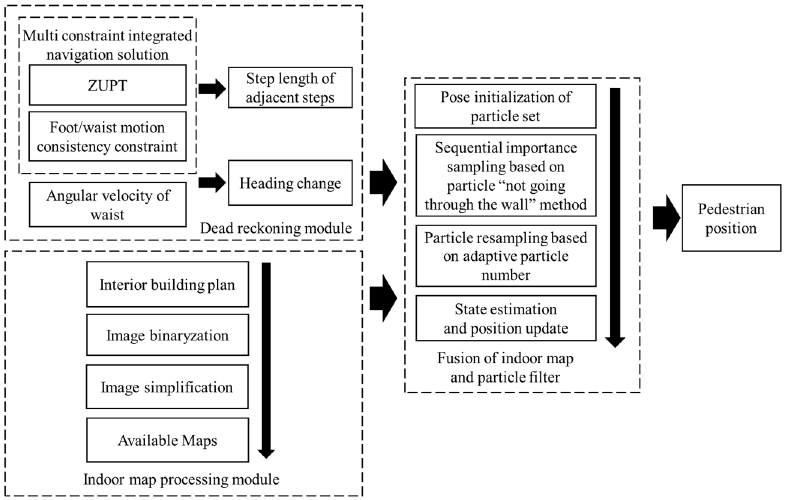
Figure 1. General scheme of the indoor pedestrian navigation and location method based on the IMAPF method.